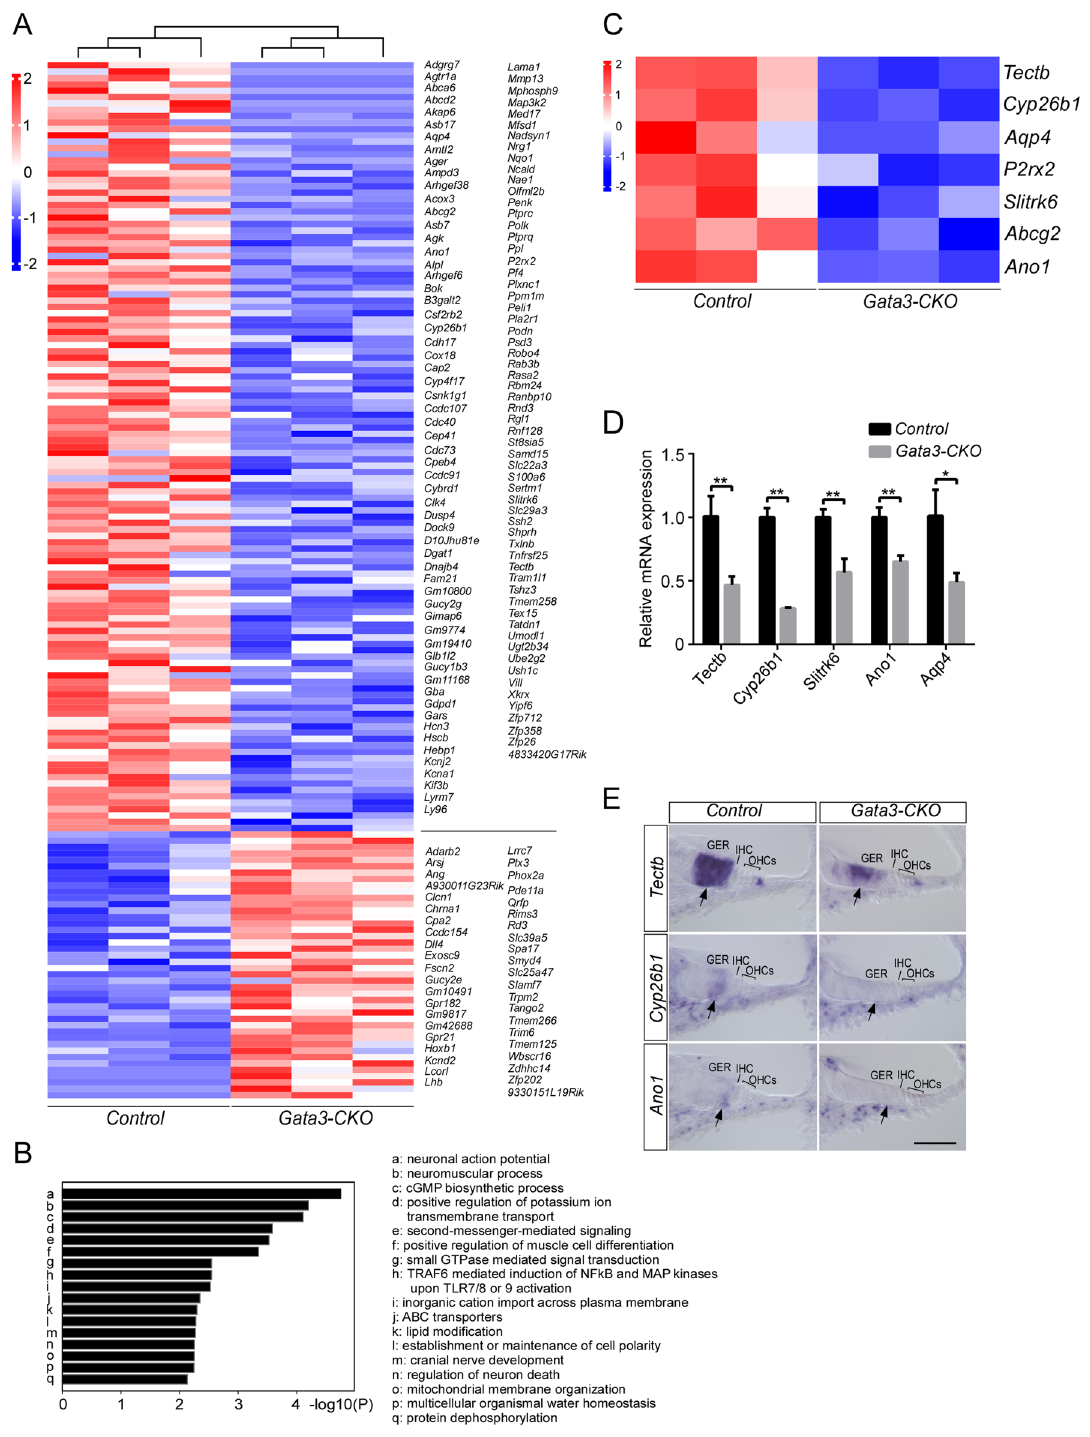
Figure 6. Transcriptome changes in the cochlear ducts of Gata3- CKO mice. ( A ) Heatmap represents the differentially expressed genes identified in the cochlear duct of Gata3- CKO mice at P4, and is divided into two clusters of control and Gata3- CKO mice. ( B ) The pathway and process enrichment analysis reveals multiple enriched terms, such as neuronal action potential, cGMP biosynthetic process, and positive regulation of potassium ion transmembrane transport. ( C ) Heatmap plot of the differentially expressed genes associated with SC function. ( D ) RT-qPCR validation of RNA-Seq results shows that the expression of Tectb , Cyp26b1 , Slitrk6 , Ano1 , and Aqp4 is significantly reduced in Gata3- CKO cochleae. n = 3; *p < 0.05; **p < 0.01. ( E ) ISH results confirm that the expression of Tectb , Cyp26b1, and Ano1 is downregulated in the GER of Gata3- CKO mice. The middle turn of the cochlea is shown. Scale bar 50